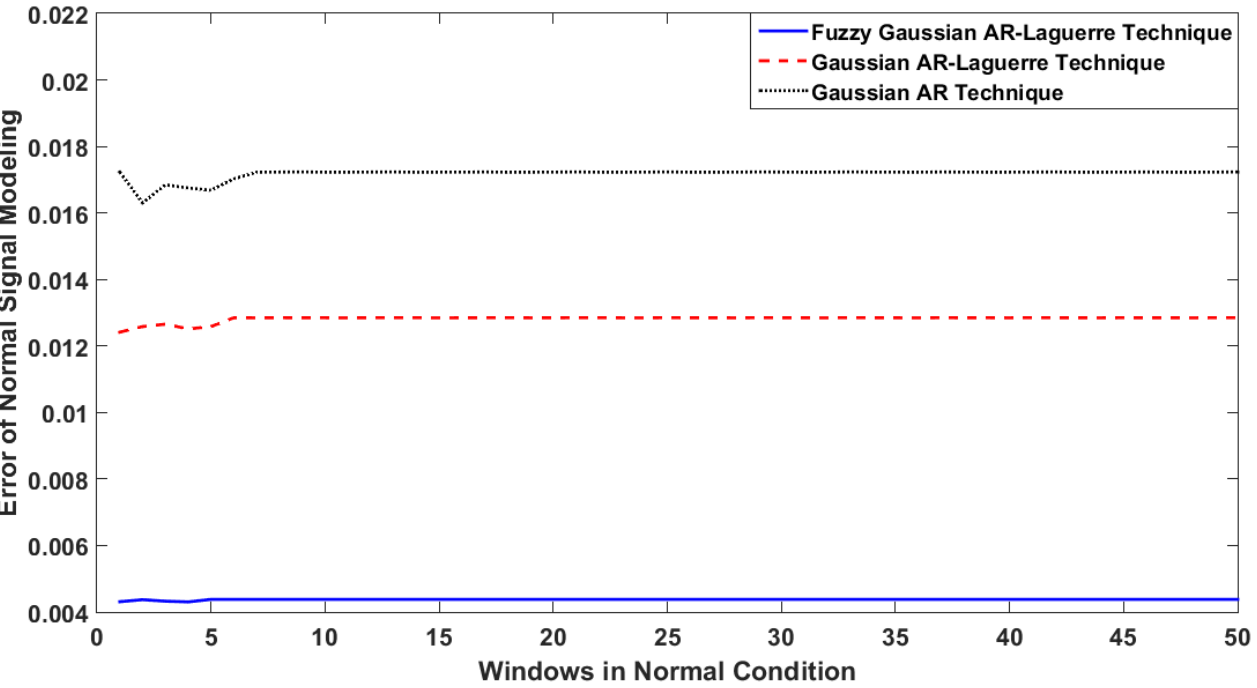
Figure 5. Error in ICE sensor modeling under normal condition according to the GA approach, the GA-Laguerre scheme, and the fuzzy GAL method.